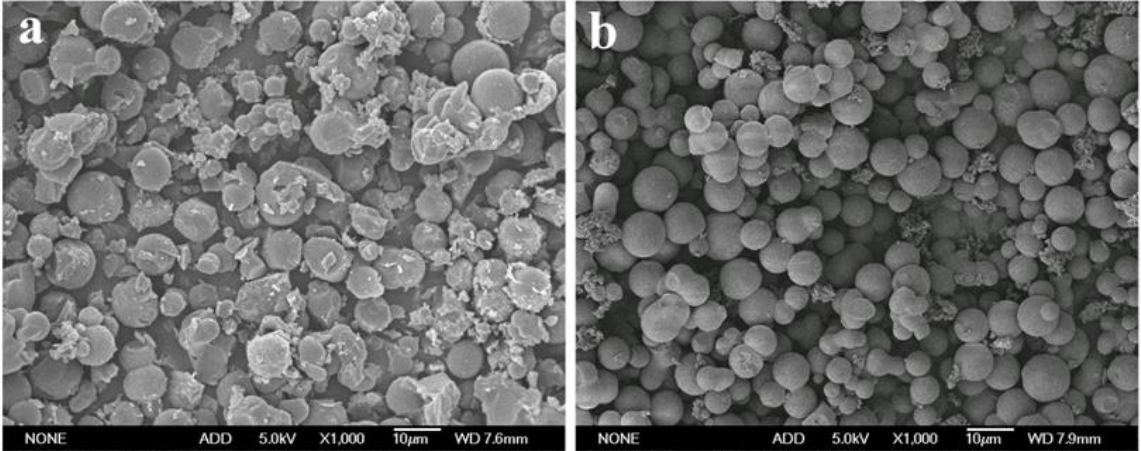
Figure 1. SEM images of the hydrothermal carbon spheres derived from hemicelluloses in ( a ) water and ( b ) 2% H 2 SO 4 at 180 °C for 12 h at a magnification of 1000x.